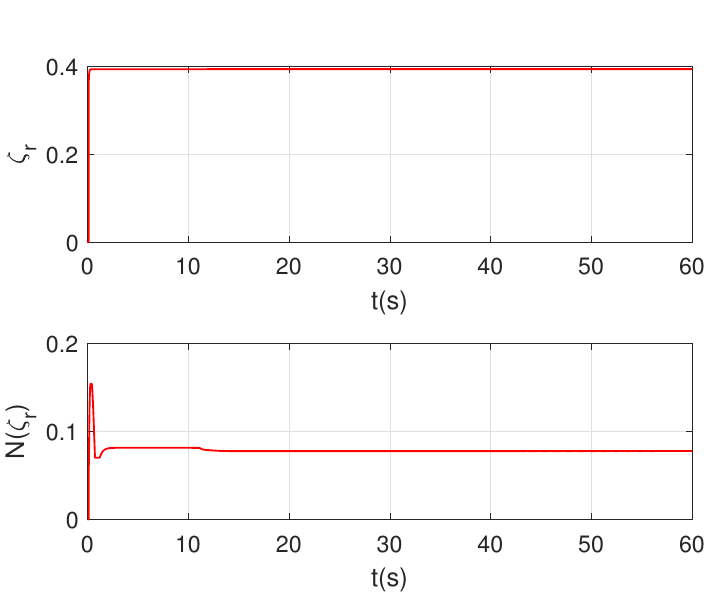
Figure 10. Nussbaum